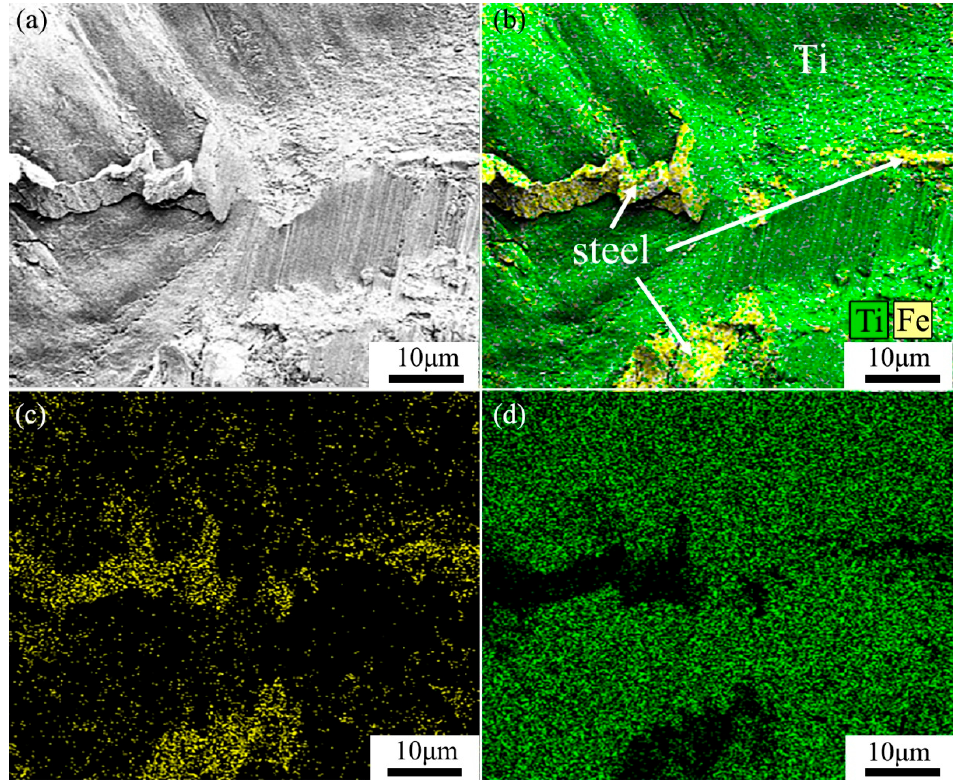
Figure 9. ( a ) Morphologies of the shear fractures of LAS / TA1 and ( b ) EDX analysis maps showing the distribution of Fe and Ti. EDX-derived elemental maps for ( c ) Fe and ( d ) Ti.